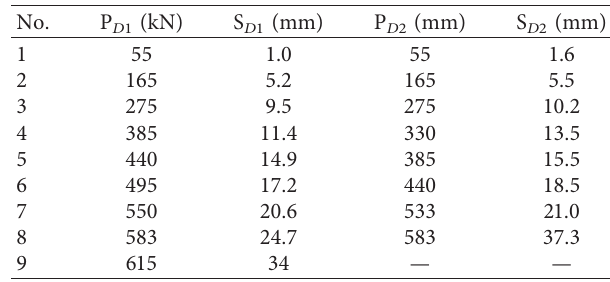
Table 13: Accuracy of each model for example 3.